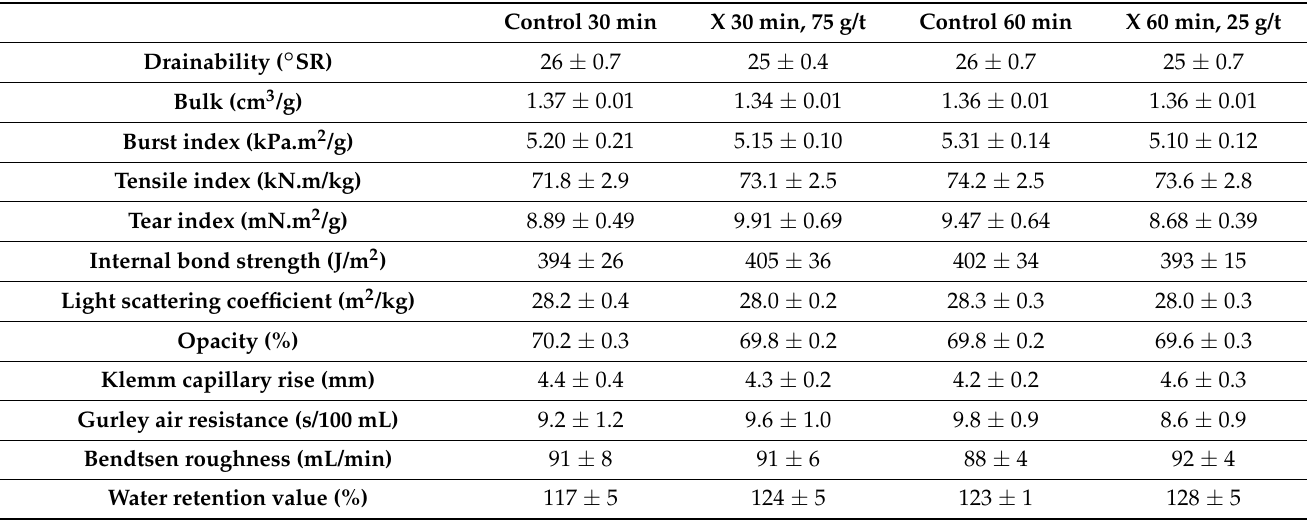
Table 3. Papermaking properties of refined bleached pulp after complete bleaching of enzyme-treated and untreated oxygen-delignified eucalypt kraft